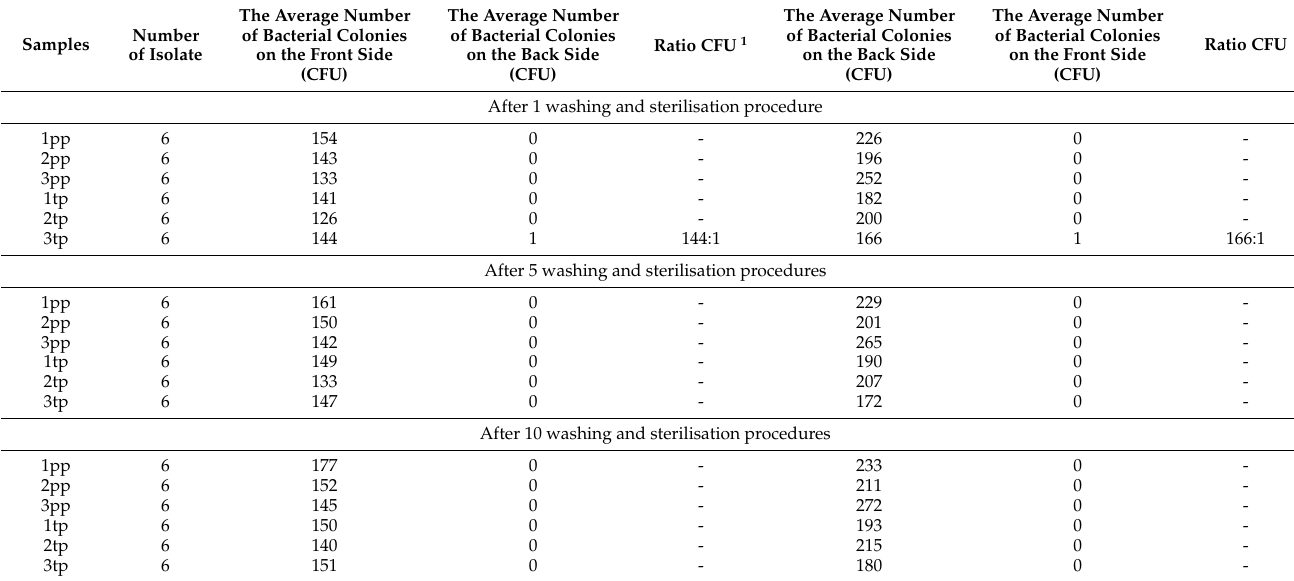
Table 6. Results of the microbial barrier permeability: average number of bacterial colonies (CFU) on the back side and the front side.